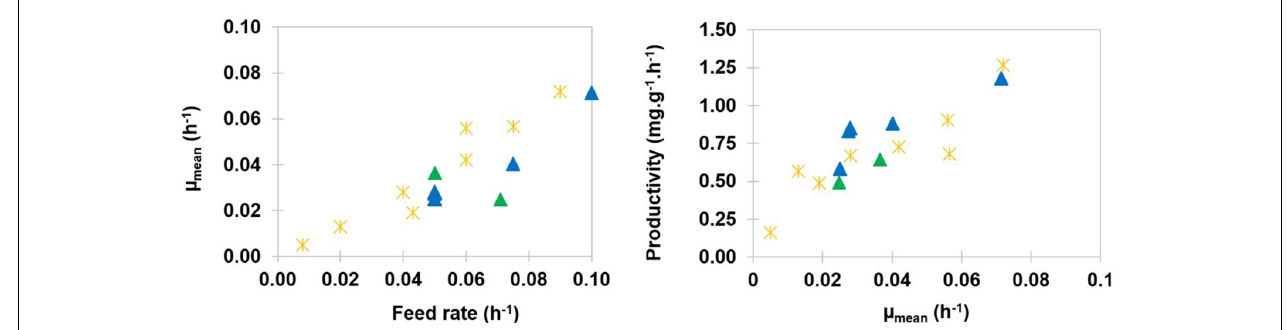
FIGURE 5 | Mean growth rate µ mean as a function of the dilution rate expressed in h − 1 (left). Specific productivity q P expressed in mg of mycosubtilin · g(DW) − 1 · h − 1 , as a function of mean growth rate µ mean expressed in h − 1 (right). Results are presented for strains BBG116 ( (cid:78) ) and BBG125 ( (cid:78) ). Results are presented with those obtained with BBG100 ( ∗ ) during previous exponentially fed-batch culture experiments (Guez et al., 2007).